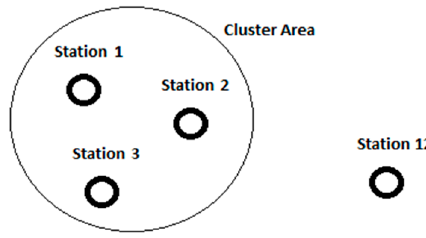
Figure 4. Task 4: the monitoring station clustering brings together geographically close sensors that are expected to record very similar data values.